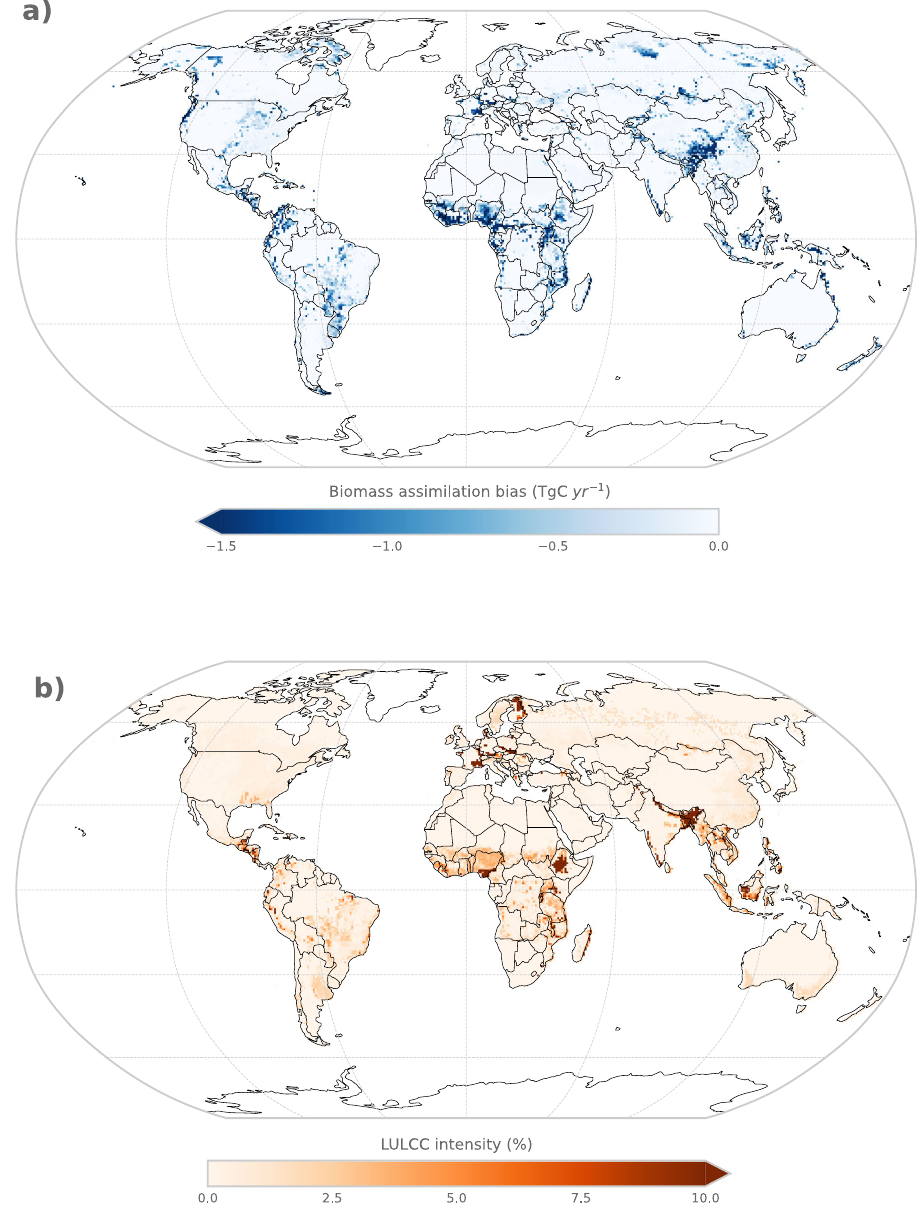
Fig. 3 | Global maps of biomass assimilation bias and LULCC intensity accord- ingtoLUH2. Thebiomassassimilationbias( a )isduetouncertaintiesintheLULCC forcing and plant functional type distribution in BLUE and is calculated as the average (2000 – 2019) difference in woody biomass carbon stocks between the assimilated time series in BLUE and the observed time series byref. 16. The LULCC